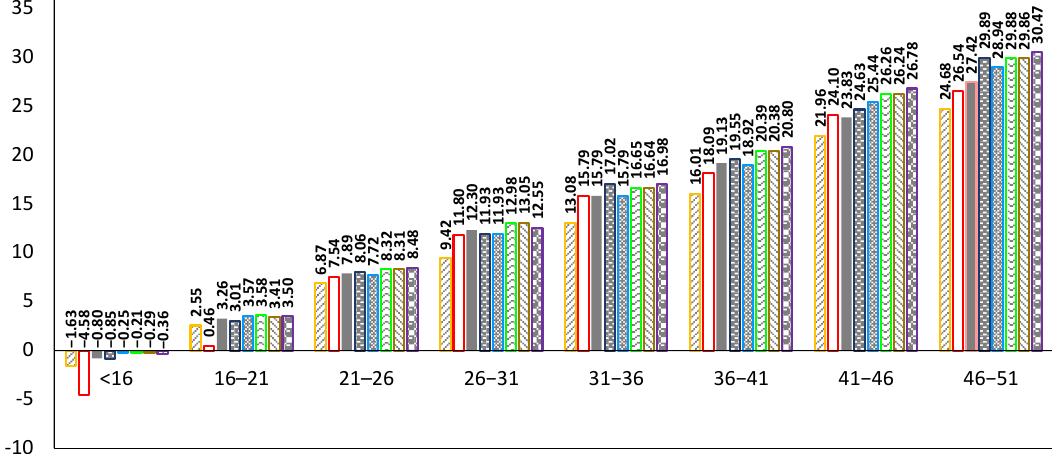
Low-Dose Images NIQE Group Figure 8. Comparison chart on NIQE scores between denoising methods. The X-axis represents the NIQE scores of the low-dose images in groups, while the Y-axis represents the amount of NIQE score improvement. Greater improvement indicates a better image